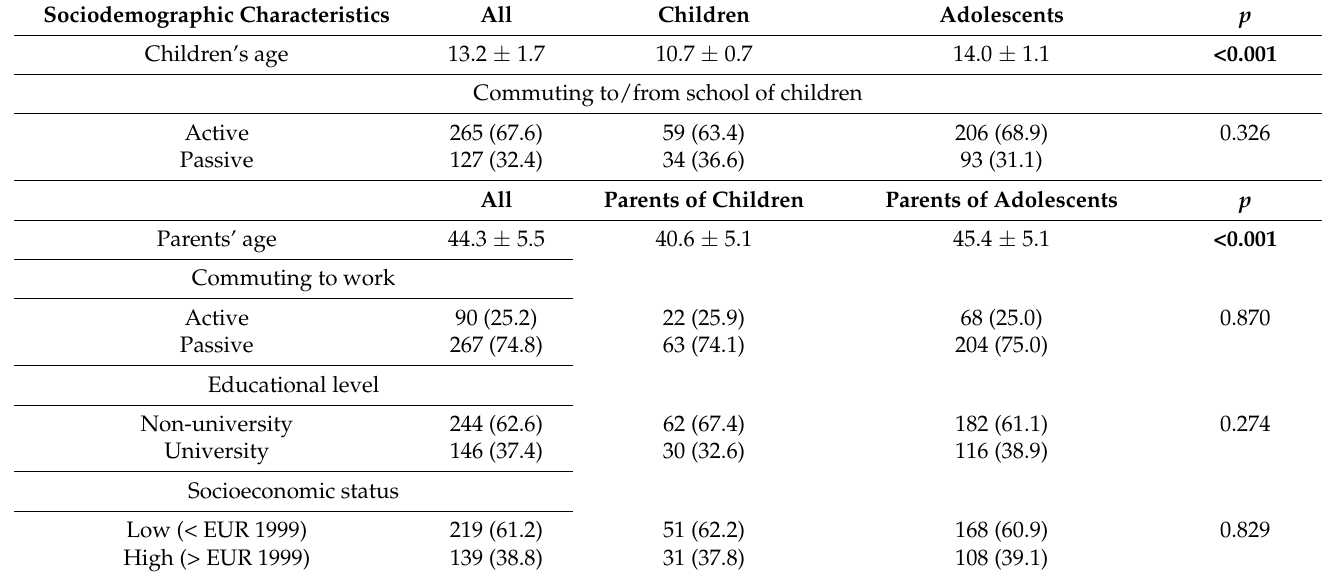
Table 2. Descriptive data of